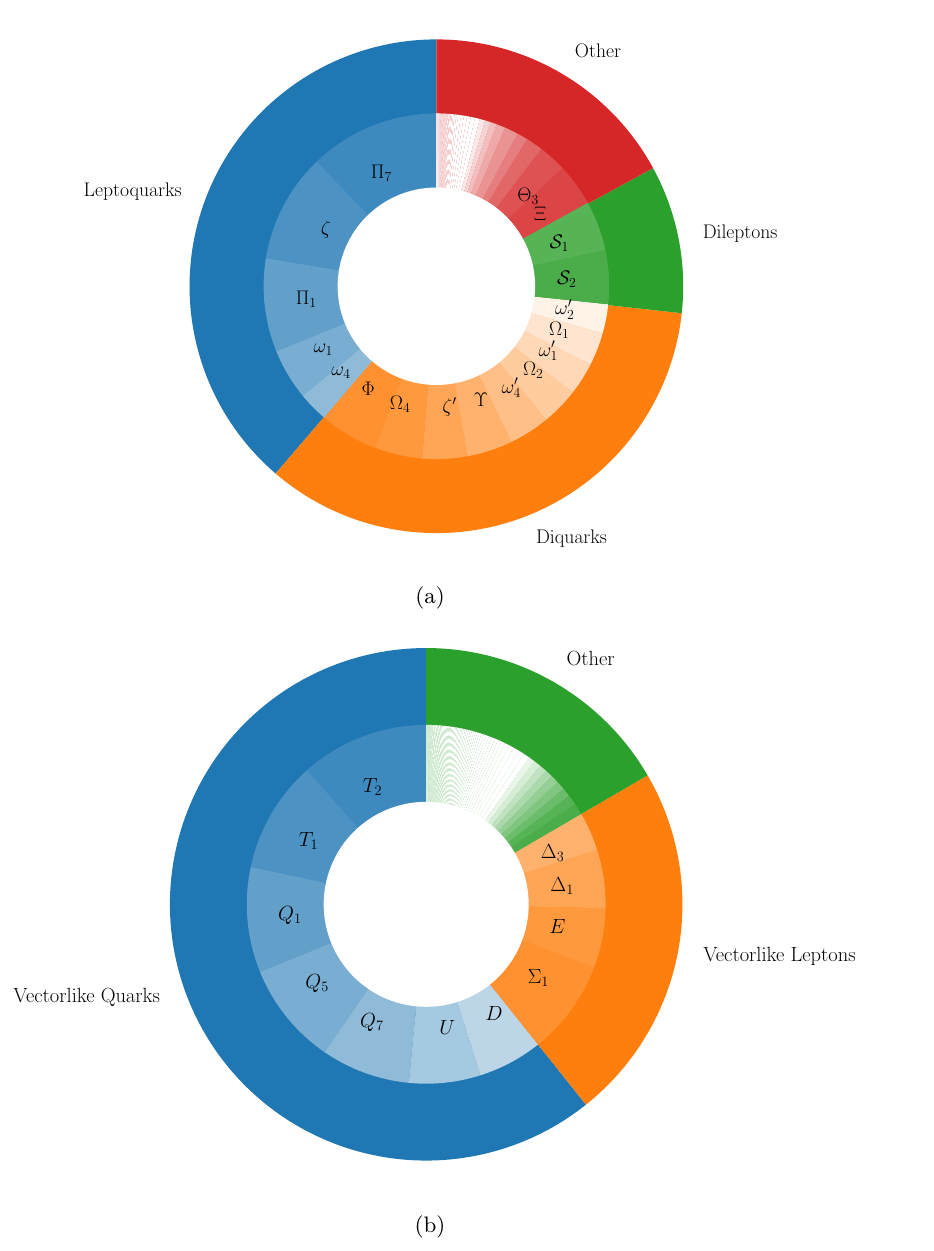
Figure 14. The number of models in which each field appears in the completions shown as a pie chart for scalars and fermions separately. The exotics are distinguished by their couplings to SM fields. (a) The pie chart of scalar fields appearing in the completions. Primed fields represent leptoquarks whose baryon-number assignment allows only the diquark couplings. (b) The pie chart of fermion fields appearing in the completions. See table 2 or ref. [38] for the convention used for the field